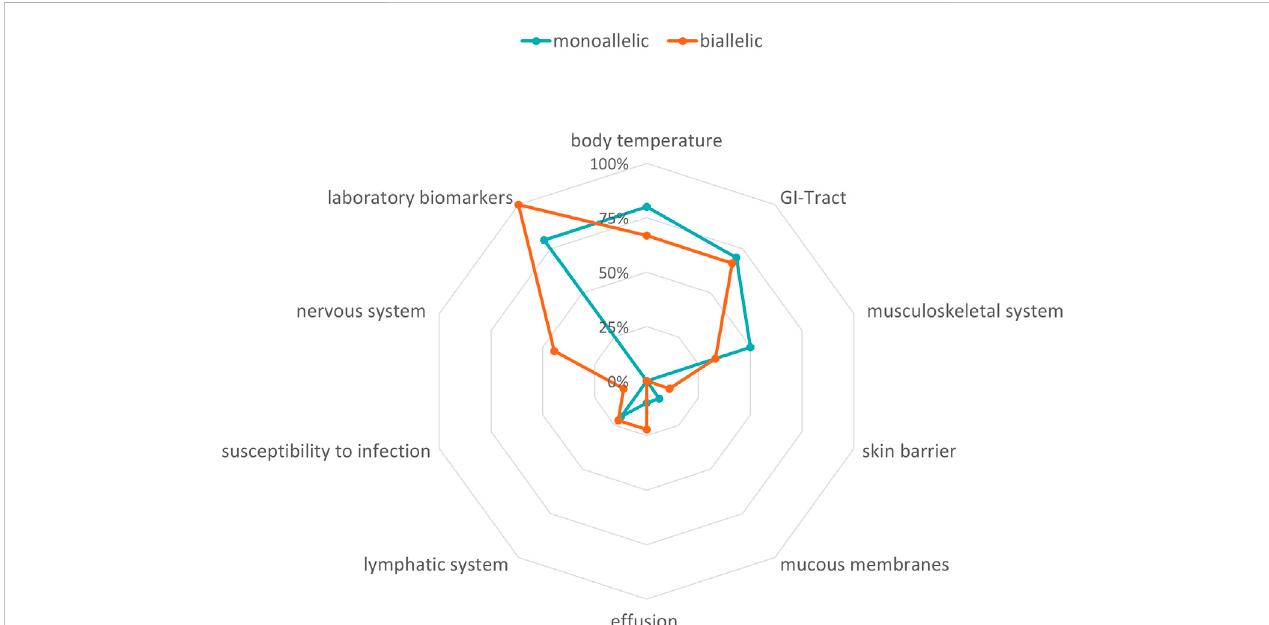
FIGURE 3 Phenotypes in FMF. Radar chart visualizing the symptoms of biallelic and monoallelic carriers of pathogenic MEFV variants depending on zygosity. Turquoise line: amount of patients with monoallelic variants in %, orange line: amount of patients with biallelic variants in